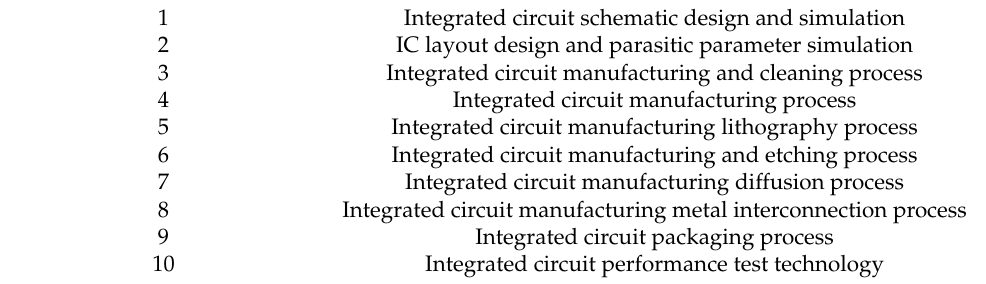
Table 2. Basic technology of integrated circuit.